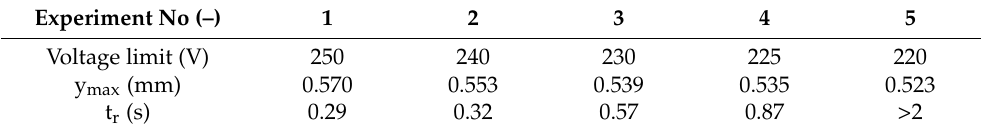
Table 5. Values of parameters in experiments with control voltage limits for two-input